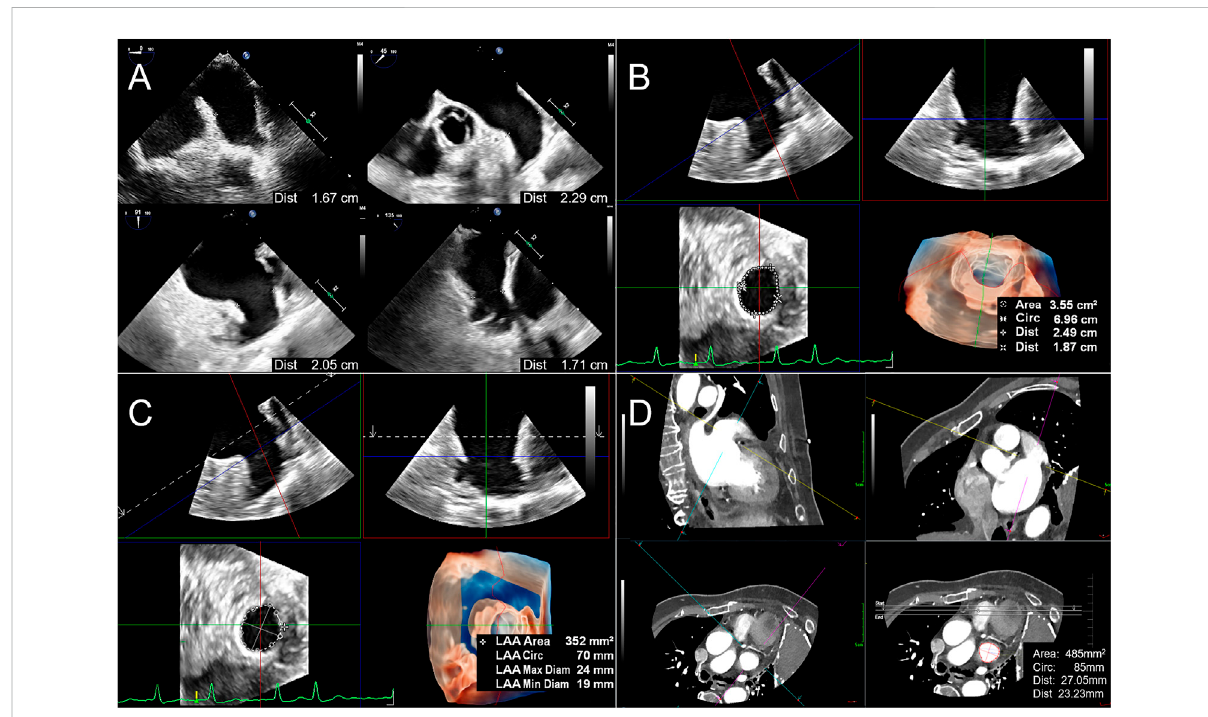
FIGURE 2 FlowchartofLAAparametermeasurementsbeforepercutaneousleftatrialappendageocclusion. (A) .For2DTEEmethod,theLAALZdiameters (LZisde fi nedasthepointfromtheleftcircum fl exarteryto1 – 2 cmbelowthecontralateralleftsuperiorpulmonaryveincrest)aremeasuredat0 ° ,45 ° , 90 ° , and 135 at end-systole, respectively. (B) . When applying 3D Manual LAA method, enter MultiVue mode on the basis of LAA 3D Zoom image, and at the end of systole, adjust the LZ positioning line (blue line) in the LAA sagittal plane (upper left), coronal plane (upper right), obtain the LAA LZ cross-section (lower left), and manually measure the LAA LZ maximum diameter (the fi rst Dist value obtained), minimum diameter (the second Dist value), area and circumference (Circ). The lower right fi gure shows 3D downward view of the LAA LZ and the measurement results. (C) . After positioning the LAA LZ in the same way as 3D Manual LAA, the above parameters are automatically obtained by clicking “ 3D Auto LAA ” (lower right). (D) . When using CCTA, measurement method is similar to 3D Manual LAA by adjusting the LZ positioning lines (yellow lines) in the sagittal plane (upper left) and coronal plane (upper right) of the LAA, obtaining the LAA LZ cross-section (lower left) and then manually measuring the above parameters in sequence (lower right). 3D Auto LAA, three-dimensional automated left atrial appendage; 3D Manual LAA, three-dimensional manual left atrial appendage; CCTA, cardiac computed tomographic angiography; LAA, left atrium appendage; LZ, landing